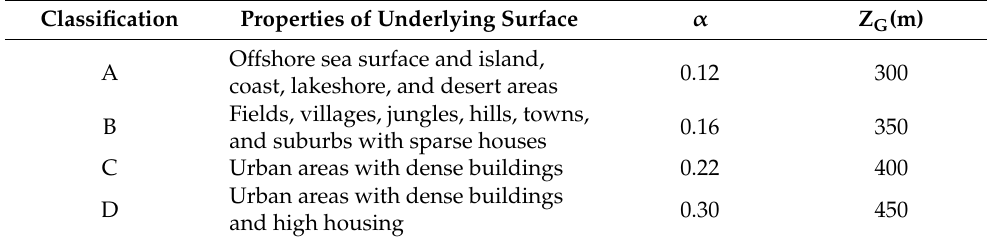
Table 3. Ground roughness index α and corresponding gradient wind height Z G